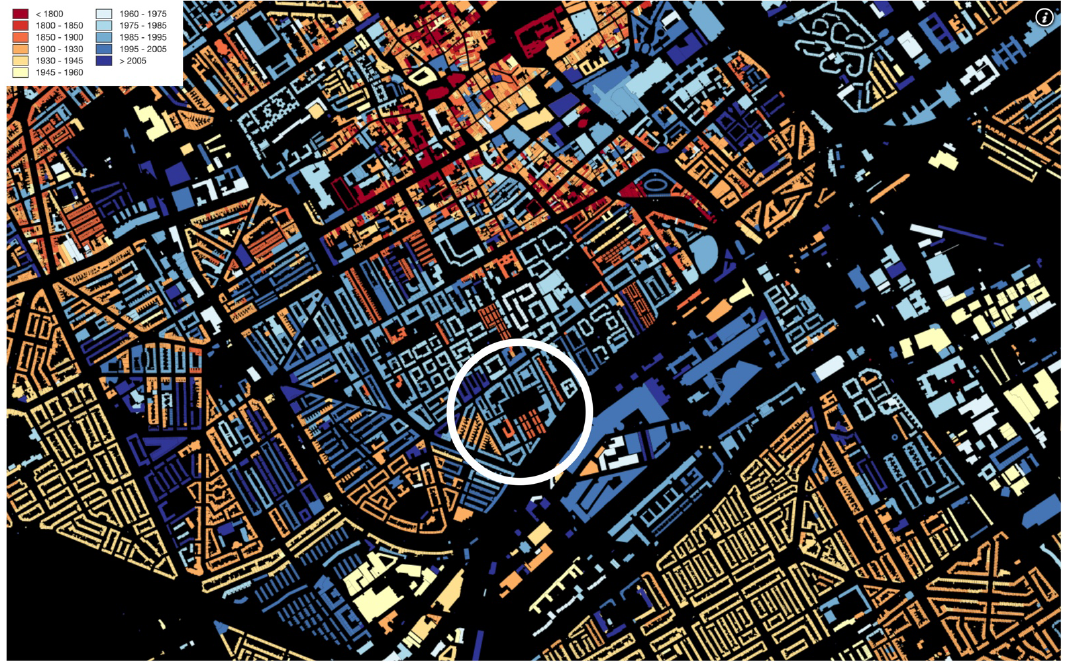
Figure 1. The location of deelgebied 5 (white circle) in the city of The Hague. Note: The colours indicate the extension of the urban renewal operation in Schilderswijk in the 1980s (blue tones adjacent to the highlighted area). Source: Spaan & Waag Society